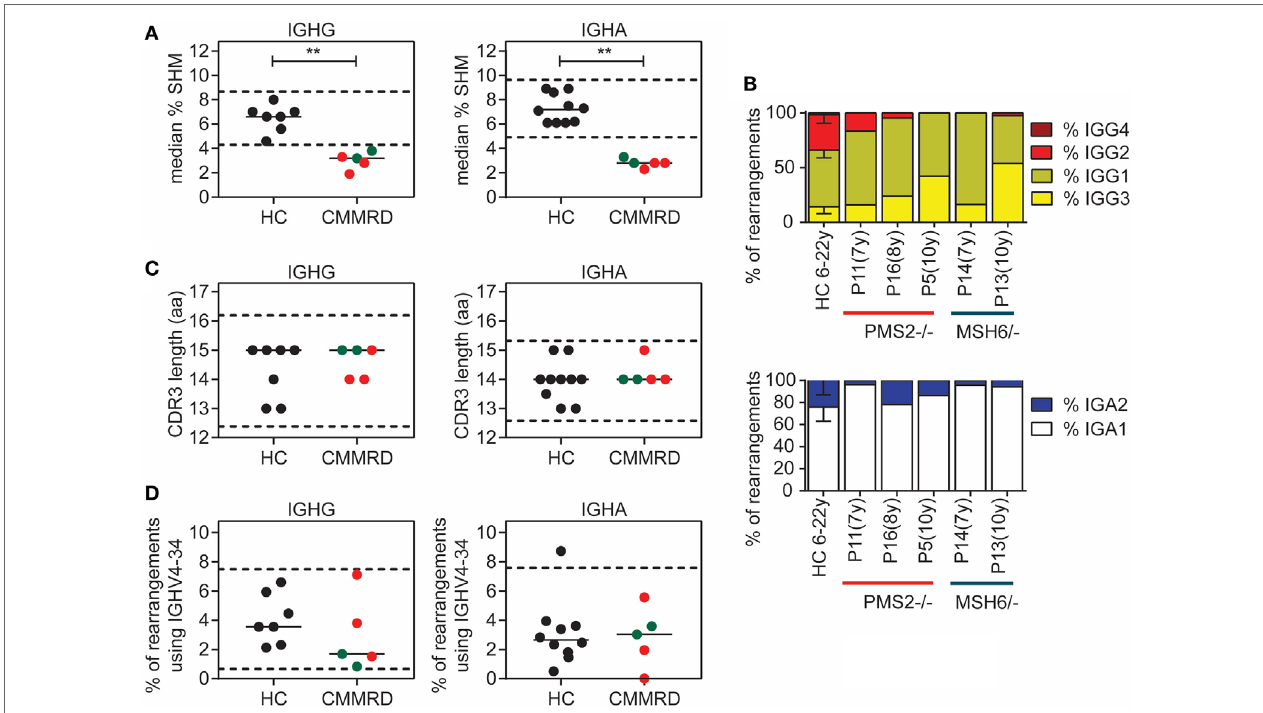
FigUre 2 | Analysis of somatic hypermutation (SHM) and class-switch recombination (CSR) in B-cell receptor rearrangements. Detailed analysis of B-cell receptor rearrangements showed significantly decreased frequency of SHM in patients with constitutional mismatch repair deficiency (CMMRD) compared to healthy controls (HC) (a) . In addition, the frequency of rearrangements that have the IGHG3, IGHG1, and IGHA1 subclass were increased in the CMMRD patients, suggesting a possible defect in CSR (B) . Selection against B cells with a long complementary determining region (CDR3) (c) , and B-cell that use the IGHV4-34 gene (D) was normal in the CMMRD patients. Red dots indicate MSH6-deficient patients and green dots indicate the PMS2-deficient patients. ** P < 0.01 and *** P <